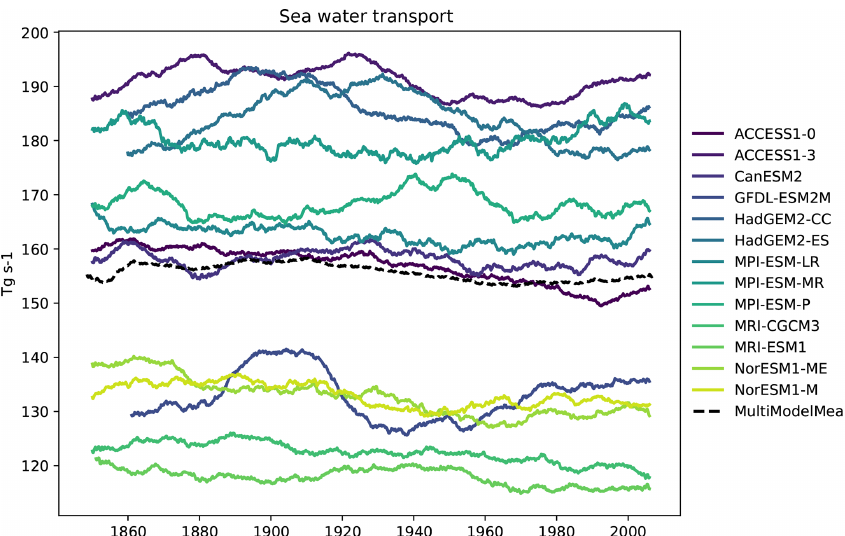
Figure 23. The Antarctic Circumpolar Current calculated through Drake Passage for a range of CMIP5 models in the historical experiment in the r1i1p1 ensemble member, with a 6-year moving average smoothing function. The multi-model mean is shown as a dashed line. Produced with recipe_ocean_amoc.yml described in Sect. 3.3.1.